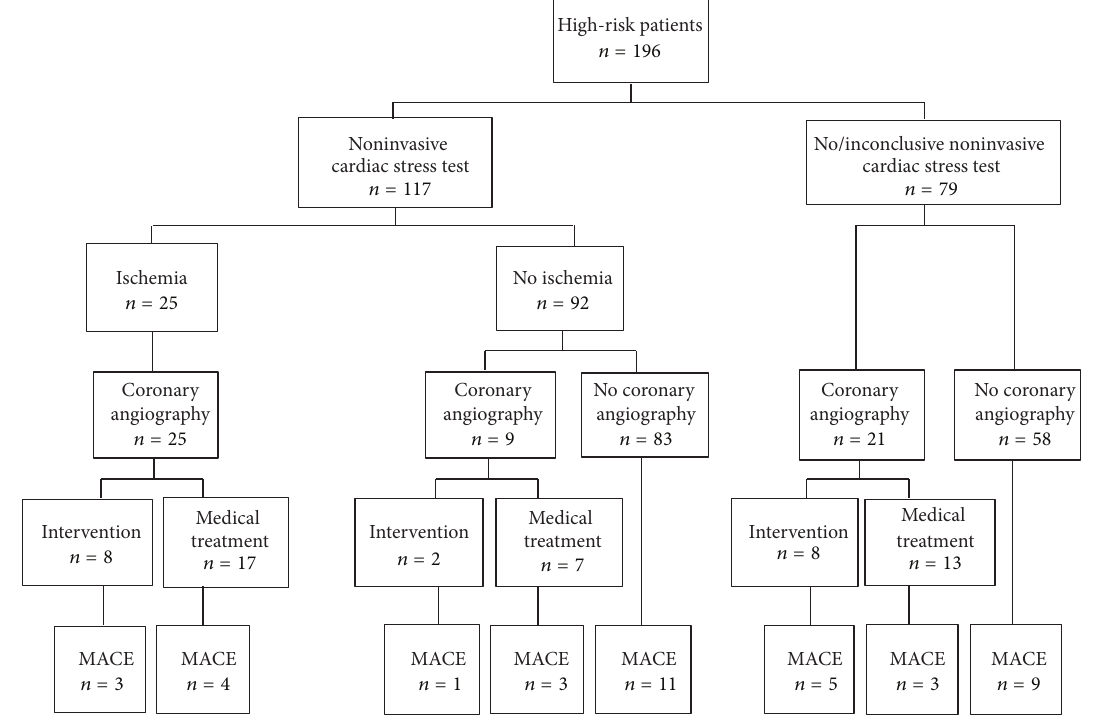
Figure 1: Cardiac evaluation procedures and cardiac events during followup in high-risk patients.